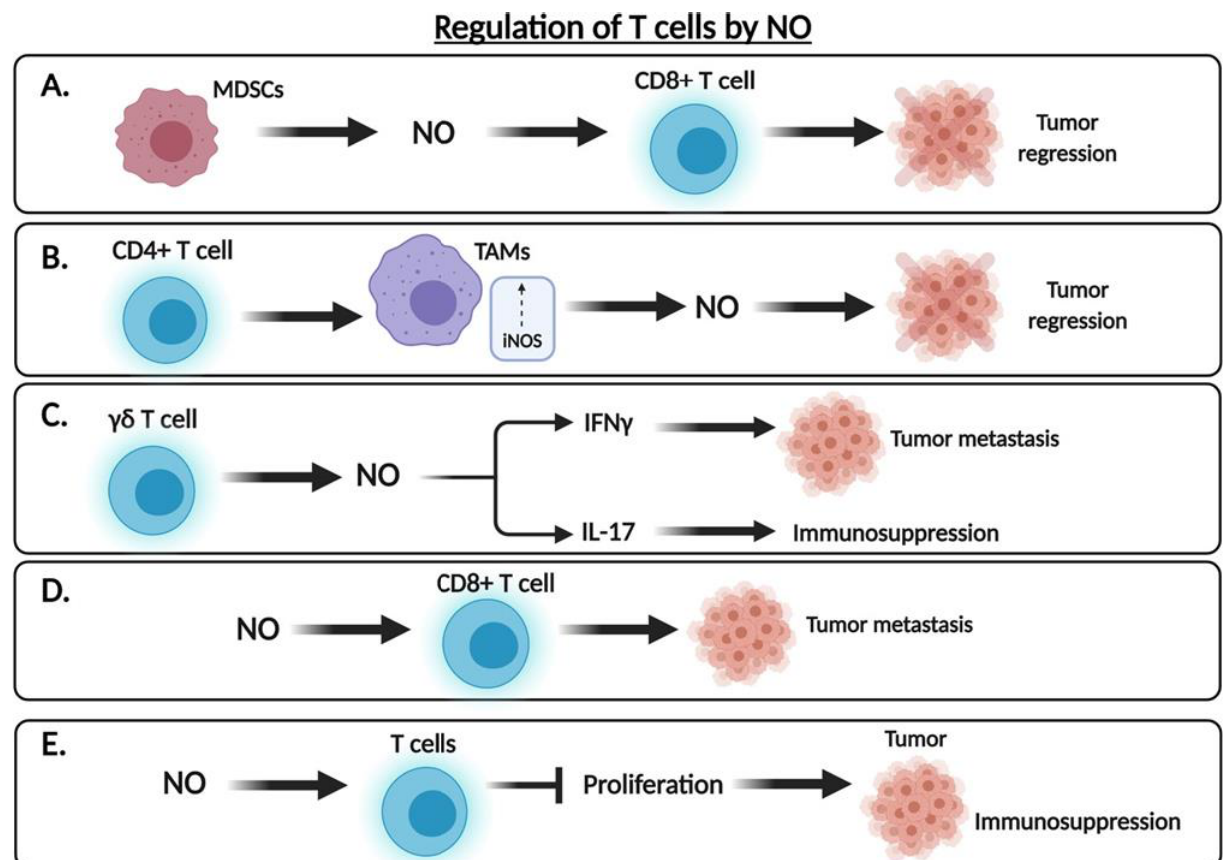
Figure 6. Regulation of T cells by .NO. Various subsets of T cells and immune cells are regulated by .NO. ( A ) The myeloid- derived suppressor cells (MDSCs) release .NO that can act on anti-tumor CD8T cells to activate their functions, resulting in tumor regression. ( B ) CD4 T cells interact with TAMS in the TME and activate iNOS, resulting in the release of .NO that may directly target and kill tumor cells. ( C ) The high level of iNOS in the gamma-delta T cells release .NO that will act on the inhibition of IFN-gamma that leads to tumor metastasis. In addition, .NO will activate Th17 cells that will result in immunosuppression. ( D ) Available .NO in the TME will act on anti-tumor CD8T cells and inhibit their functions and lead to tumor progression and metastasis. ( E ) Available .NO will act on T cells and inhibit their proliferation leading to immunosuppression .